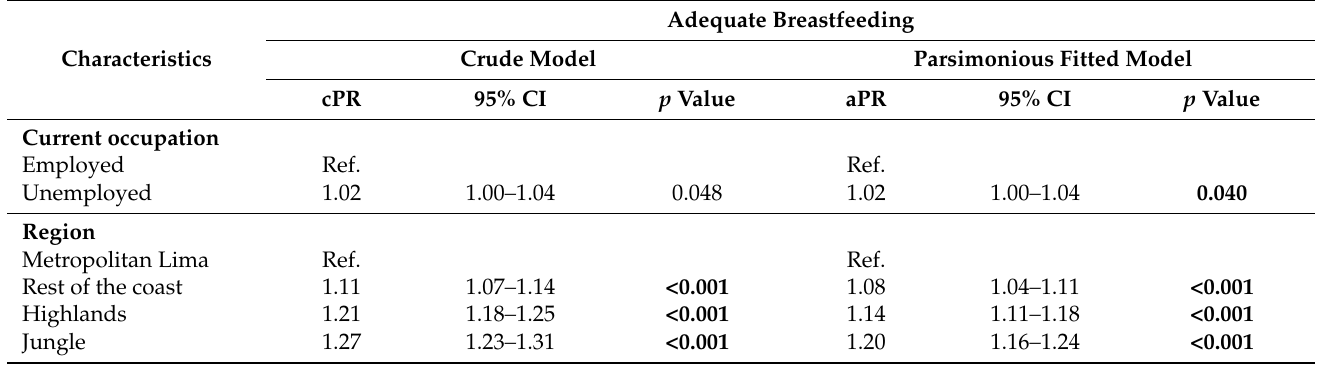
Table 3. Factors associated with adequate